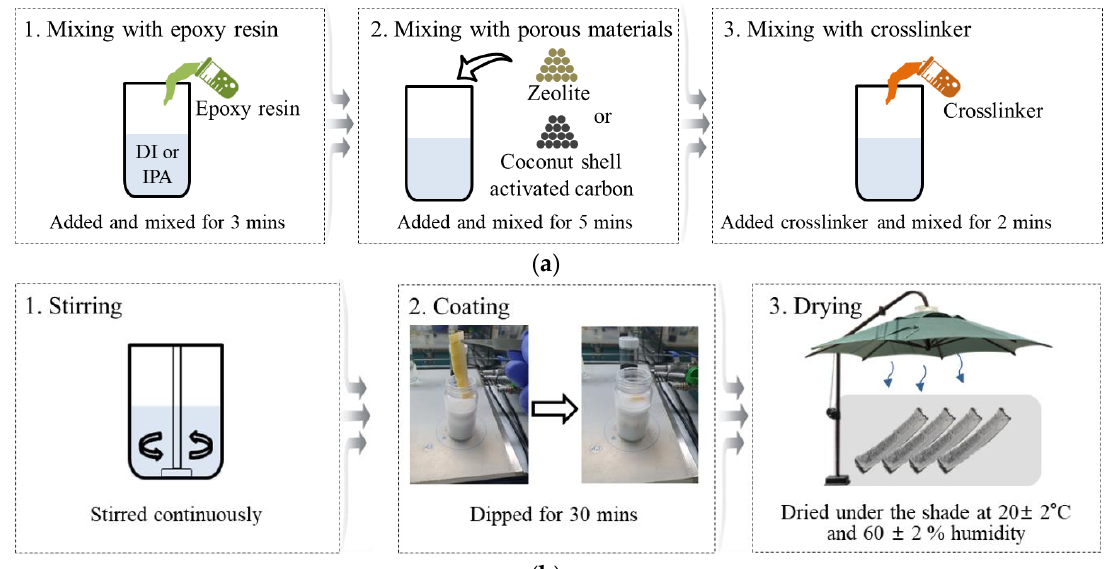
Figure 2. Coating method of the textile fabrics. ( a ) Producing dilution solution for coating. ( b ) Coating and drying.